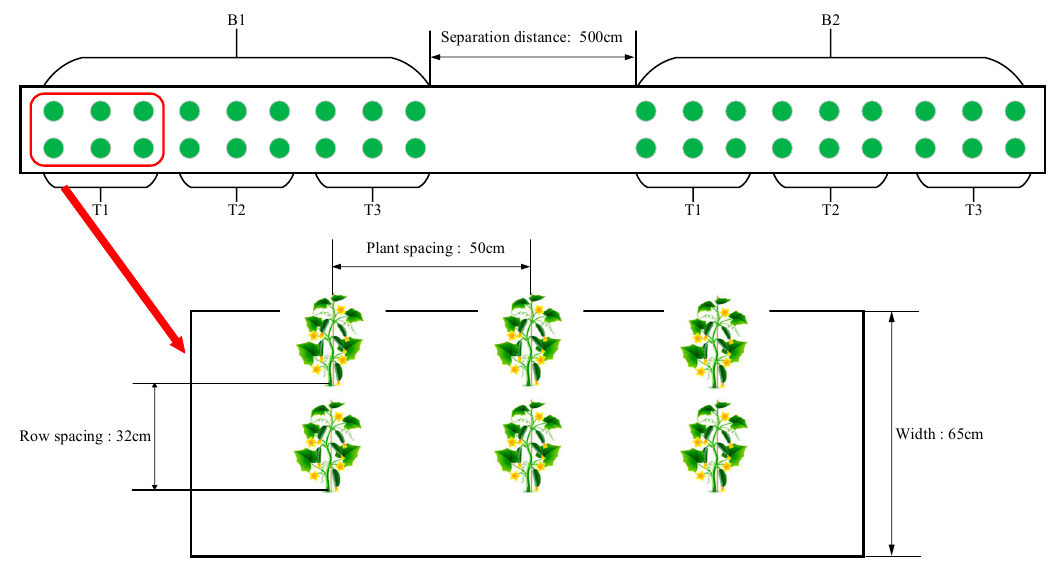
Figure 1. Diagram of cucumber planting.